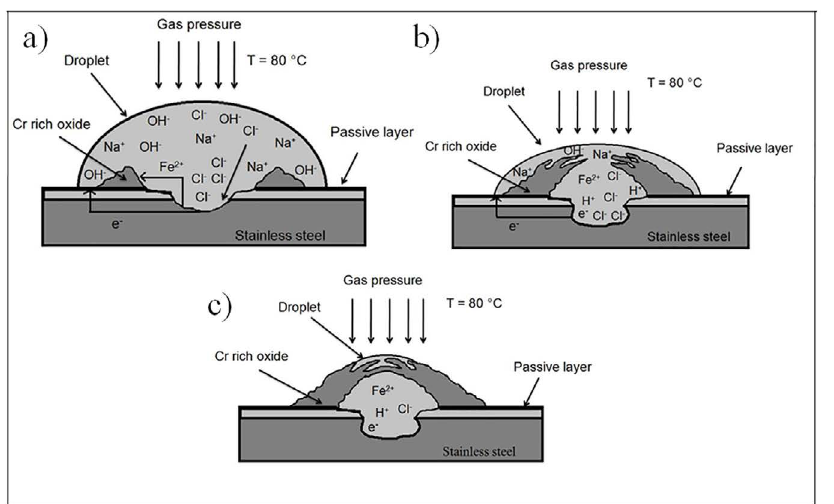
Figure 18. Schematic illustration of the mechanism of pitting initiation (a), growth (b) and final stage (c) on the surface of the 316L steel. The pit becomes deeper with time while the droplet